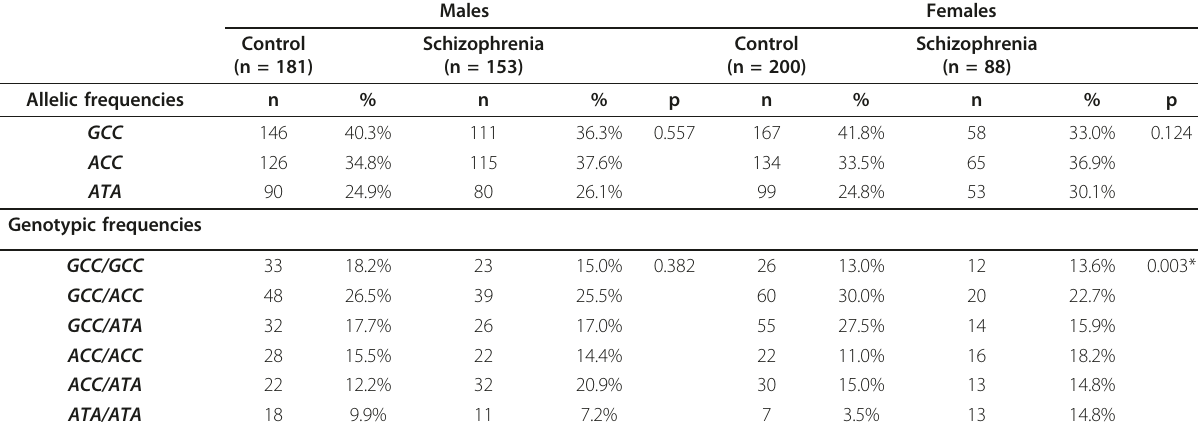
Table 2 Allelic and genotypic frequencies of IL-10 gene promoter haplotypes in schizophrenic and healthy males and females Males Females